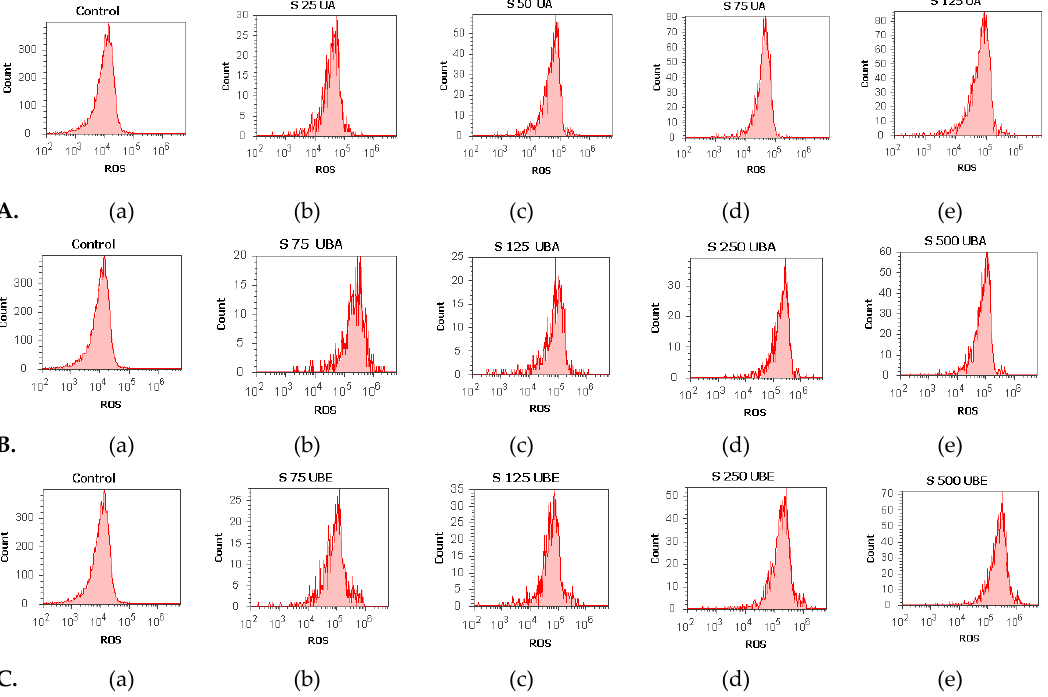
Figure 9. Reactive oxygen species (ROS) status of UA, UBA, and UBE treatments in normal blood cell cultures. ROS patterns of UA 25, 50, 75, 125 μ g/mL A ( b – e ); B ( b – e ) UBA 75, 125, 250, 500 μ g/mL; C ( b – e ) UBE 75, 125, 250, 500 μ g/mL reported to 1% DMSO ( A ( a ), B ( a ), C ( a )). (Figure 9B(a,b)) compared with 1% DMSO: 21.00 × 10 4 ± 1.00 vs. 10.40 × 10 4 ± 1.00 ( p < 0.001, Figure 10b).